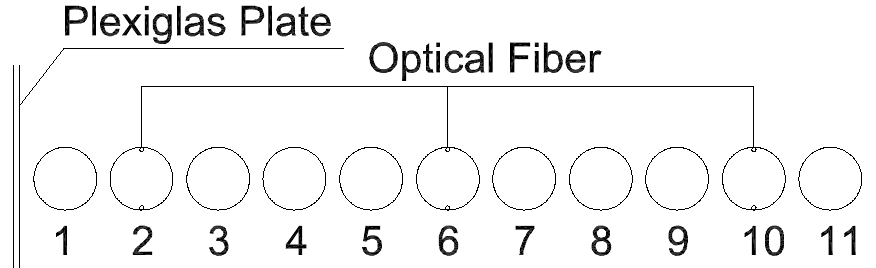
Figure 5. The distribution diagram of the fibers.